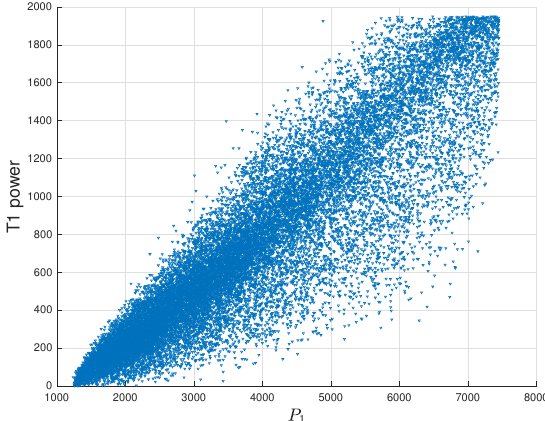
Figure 5. y (power of T1) as a function of the power of T4. D bef data set.